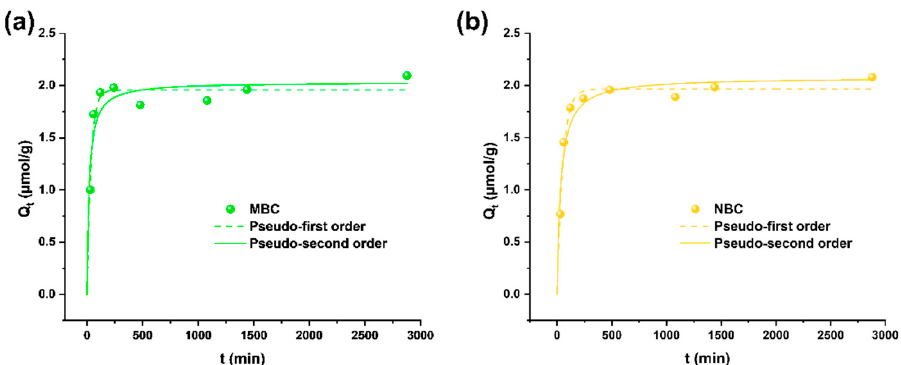
Figure 2. Adsorption kinetics of MBC ( a ) and NBC ( b ) in 5 µmol/L Pb solutions in ultrapure water. Pseudo first-order and pseudo second-order fittings are depicted as dashed and solid lines, respectively.